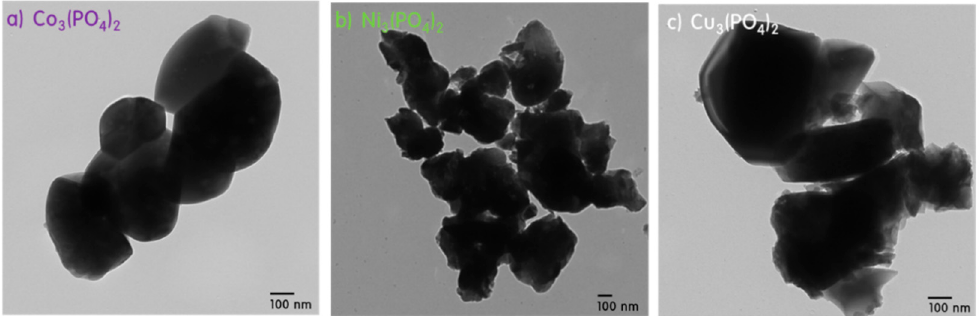
Figure 2. Transmission Electron Microscope ( TEM) images of the ( a ) Co 3 (PO 4 ) 2 -Co 2 P 2 O 7 mpc, ( b ) Ni 3 (PO 4 ) 2 mpc, ( c ) Cu 3 (PO 4 ) 2 -Cu 2 P 2 O 7 mpc.